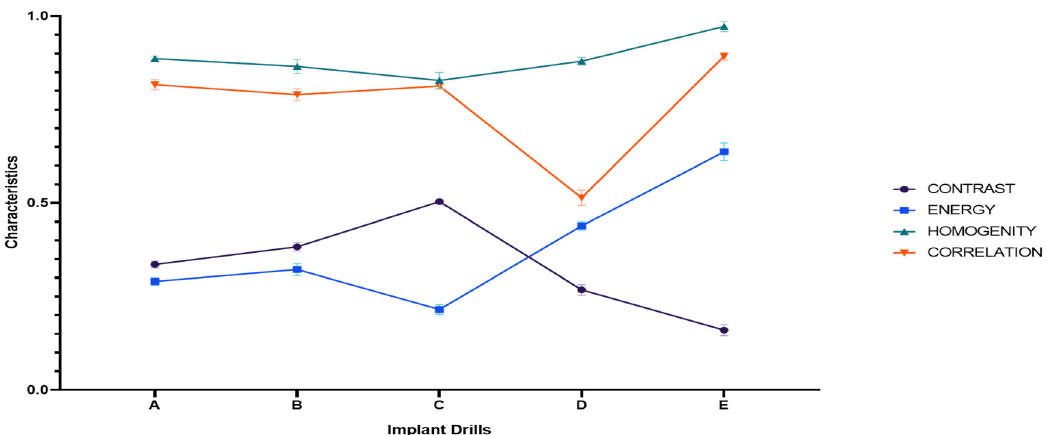
Figure 12. Graphic representation of the mean values of the different characteristics in the implant drills analyzed.